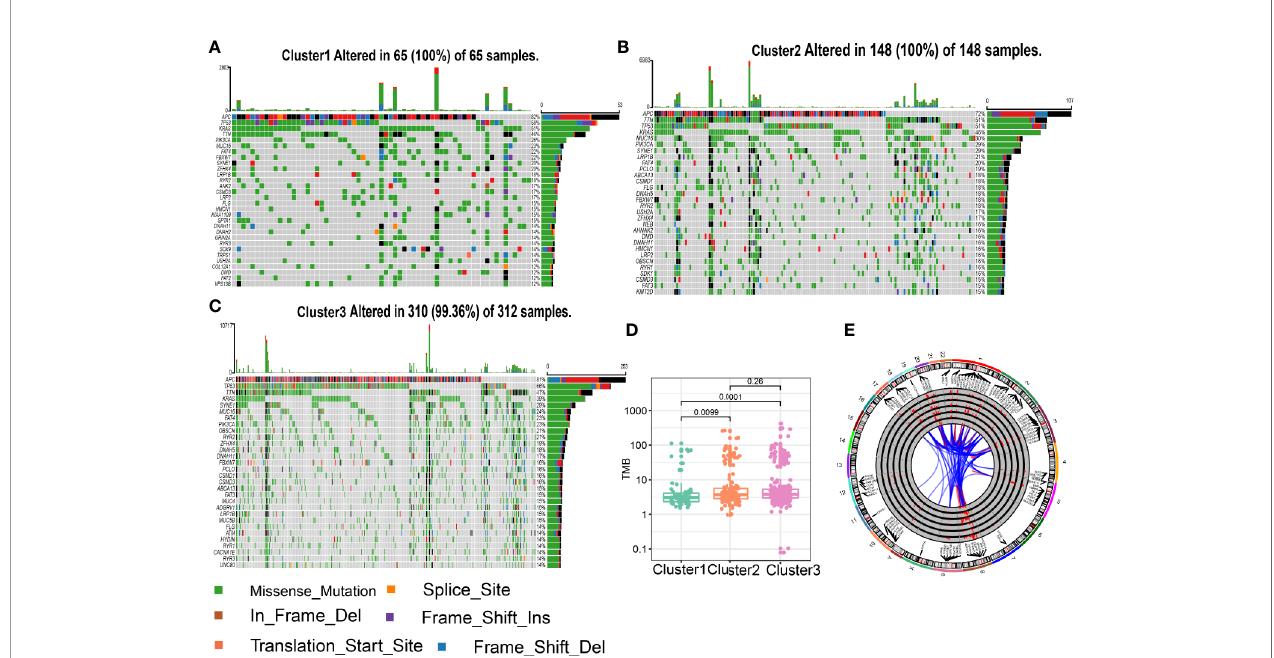
FIGURE 3 | Characteristics of tumor genome variation in different clusters. (A) Genes with top 30 mutation frequency in Cluster1. (B) Genes with top 30 mutation frequency in Cluster2. (C) Genes with top 30 mutation frequency in Cluster3. (D) Tumor mutation load (TMB) level in different clusters. (E) Circular visualization of the copy number variant (CNV) alteration in each cluster. The outermost circle shows the location of the CNV gene. The histogram shows the frequency of CNV in in different clusters. From outside to inside: genes signi fi cant deletion in Cluster1, signi fi cant ampli fi cation in Cluster1, signi fi cant deletion in Cluster2, signi fi cant ampli fi cation in Cluster2, signi fi cant deletion in Cluster3, signi fi cant ampli fi cation in Cluster3. The link lines dedicated gene